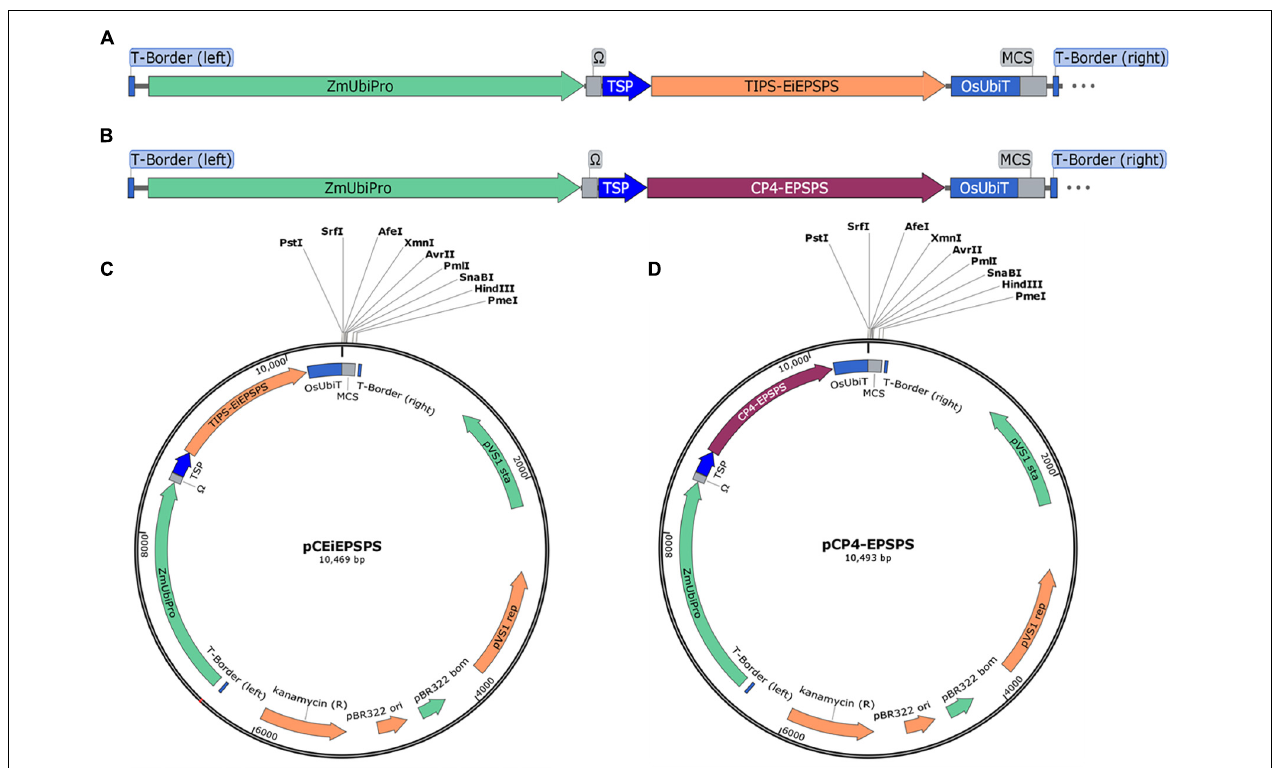
FIGURE 1 | Schematic representation of the plant binary expression vector. (A,B) The expression cassette of TIPS - EiEPSPS and CP4-EPSPS , respectively. (C,D) The plant binary expression vectors pCEiEPSPS and pCP4-EPSPS containing the EiEPSPS expression cassette and CP4-EPSPS expression cassette, respectively, with the same multiple cloning sites (MCS). ZmUbipro, maize ubiquitin promoter; (cid:127) , enhancer; TSP, chloroplast target peptide from tobacco; OsUbiT, rice ubiquitin terminator; MCS, multiple cloning